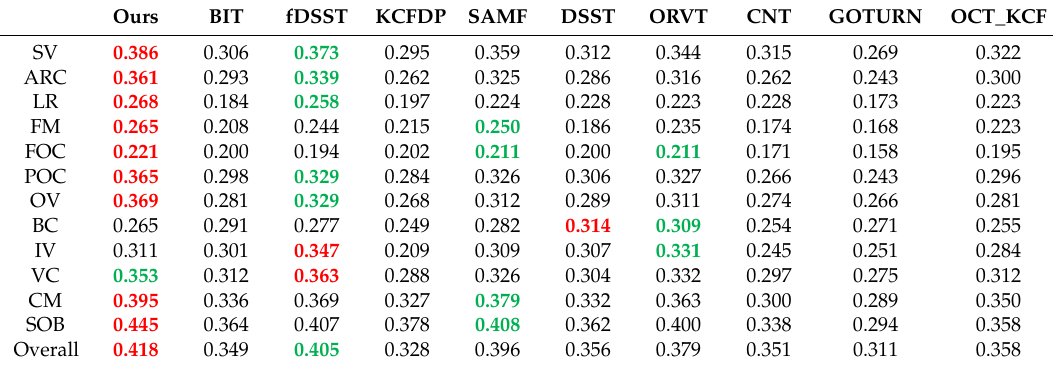
Table 2. Overall success rates on different attributes, where the entries in red denote the best results and the ones in green indicate the second